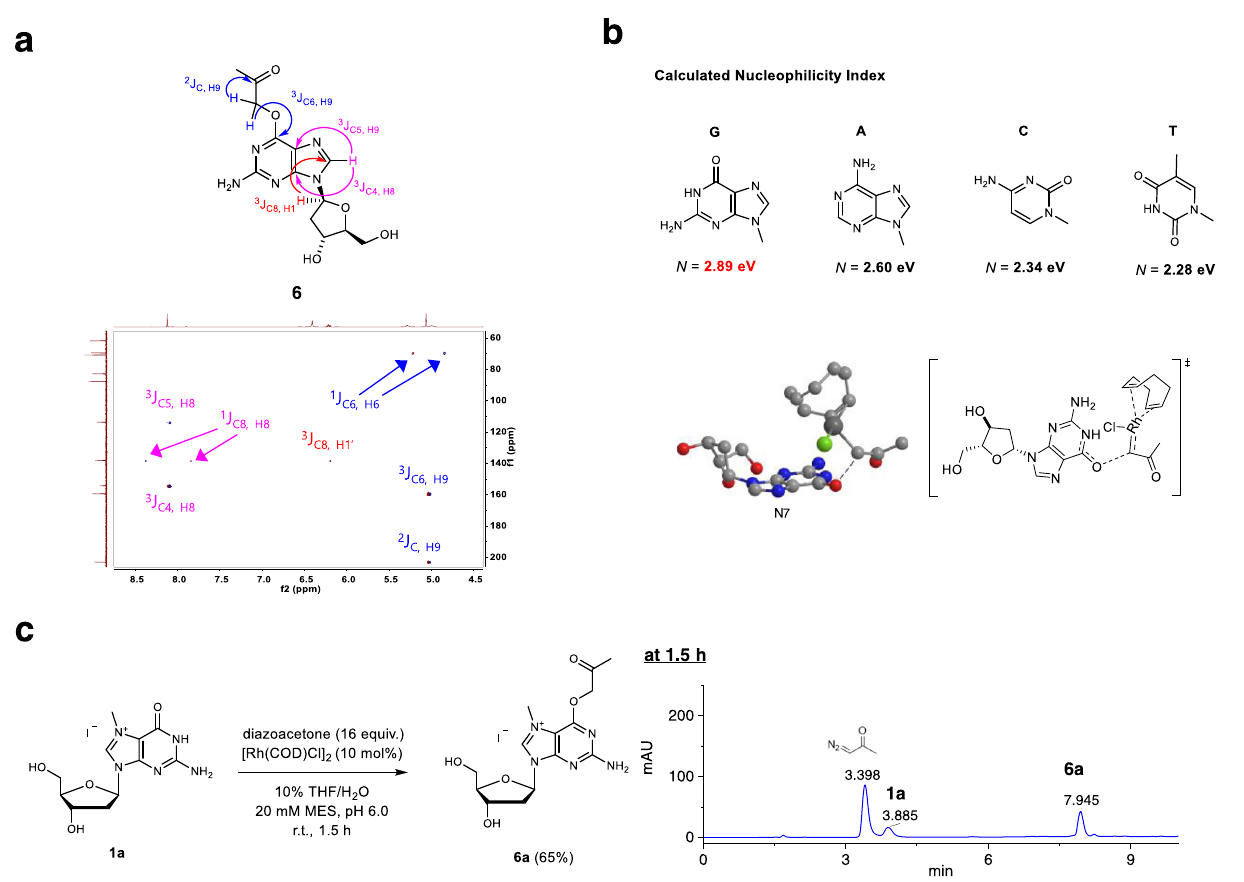
Fig. 3 Structure and mechanistic analysis of Rh(I)-catalyzed O 6 -G labeling. a Expanded 1 H- 13 C HMBC (DMSO-d 6 ) spectrum of 6 . b Calculated nucleophilicity index of four canonical nucleobases (A, T, G, and C); transition state geometry of the catalyst approaching guanosine obtained by DFT calculations. c Reaction performed with N 7 -methyl-2 ′ -deoxyguanosine and its HPLC